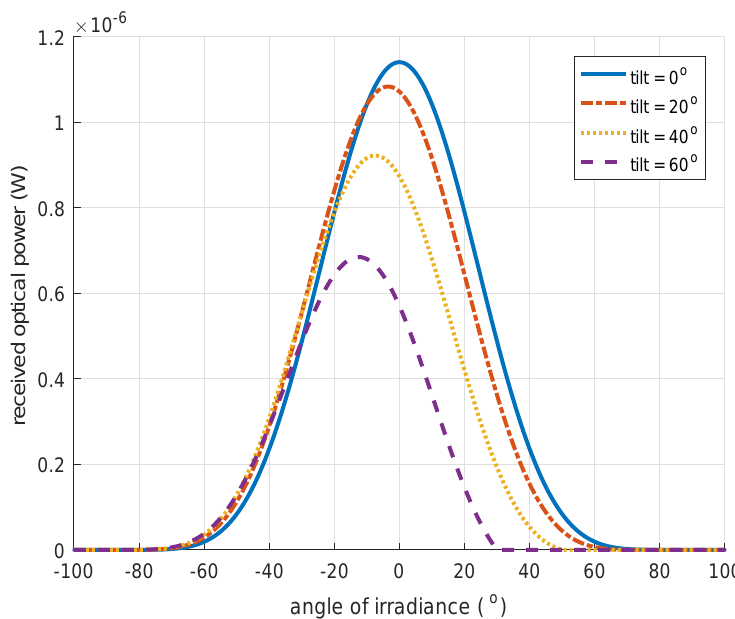
Figure 4. Received optical power from LED 2 for a horizontally moving receiver when tilted at 0 ◦ , 20 ◦ , 40 ◦ , and 60 ◦